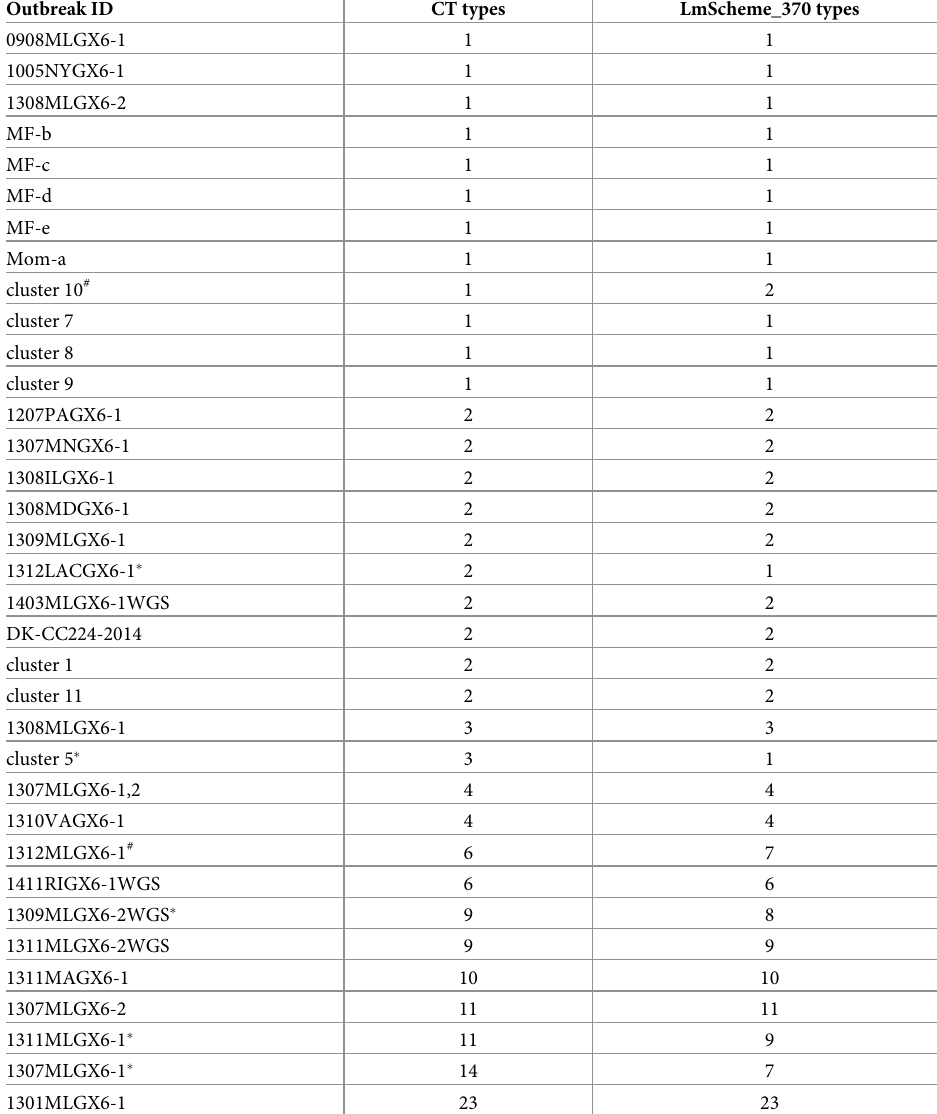
Table 1. The comparison of CT types and LmScheme_370 types for each outbreak in Set B.